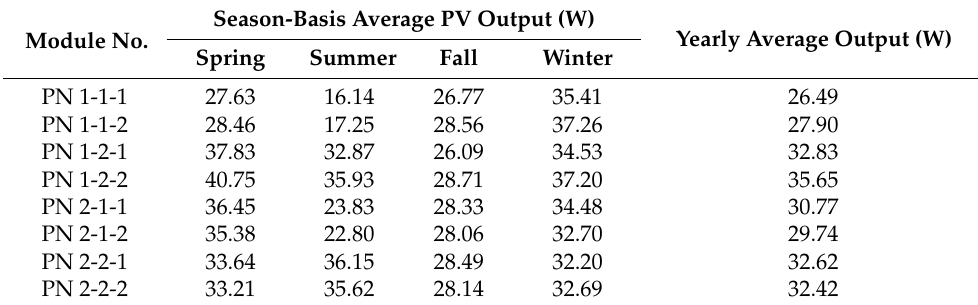
Table 5. Output characteristics of aged PV modules by season. Module